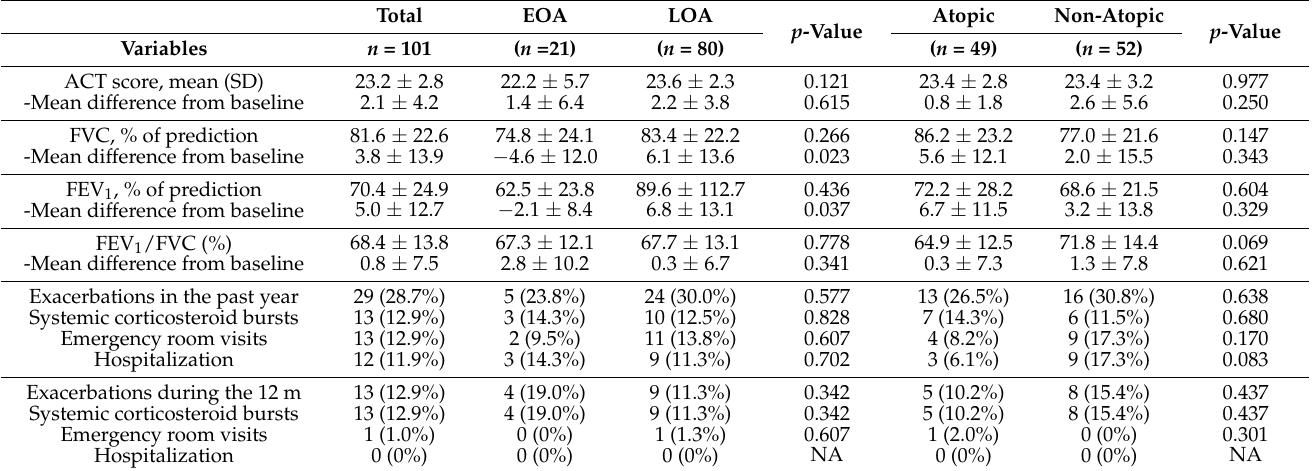
Table 2. Clinical outcomes of patients with asthma after 12-month treatment.